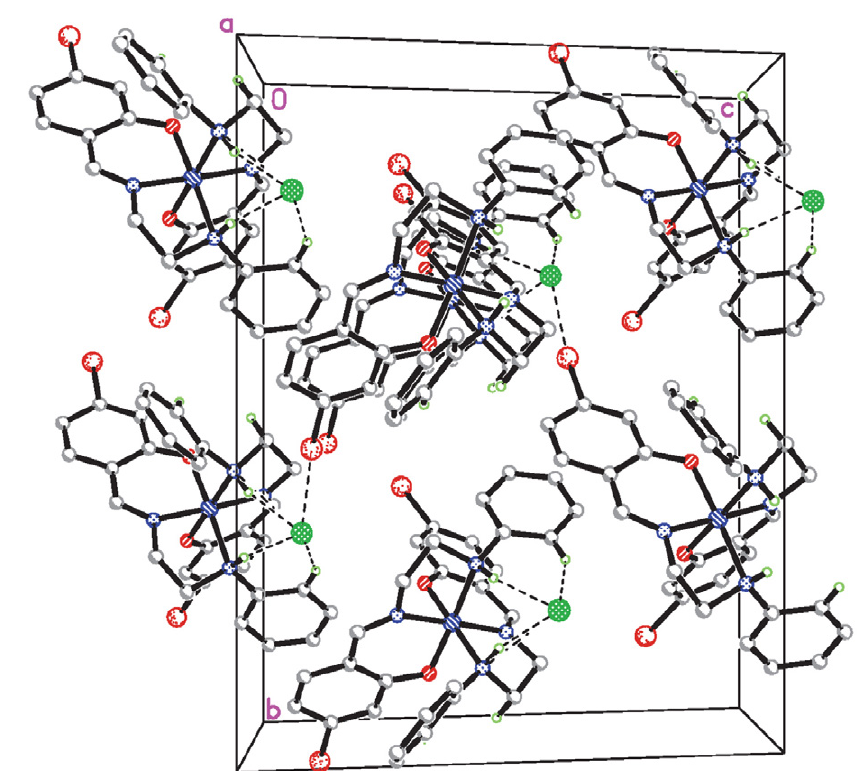
Fig. 4. Molecular packing diagram of complex 2 , viewed along the a axis. Hydrogen bonds are drawn as dashed